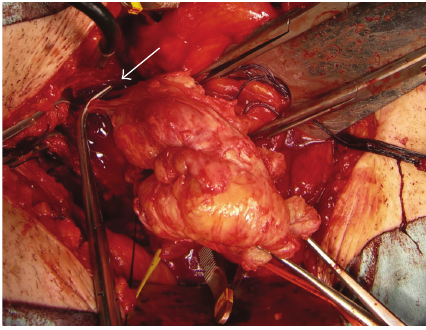
Figure 3: Clamping of vessels flowing into prostatic adenoma un- der clear vision (white arrow).